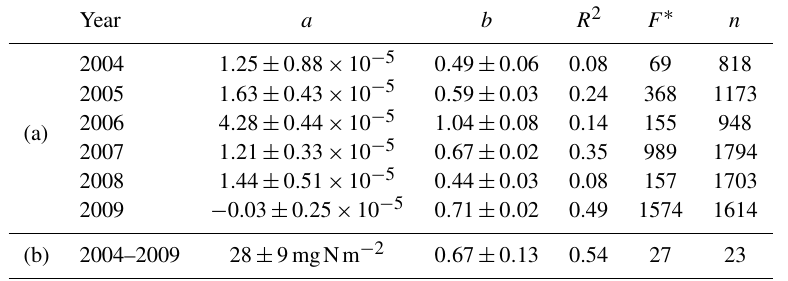
Table 3. Intercepts ( a ), slopes ( b ), coefficients of determination ( R 2 ), ratios of mean squares for regression vs. error ( F ), and number of data pairs from regressions of (a) log-transformed 4h averages of N 2 O fluxes (mgNm − 2 h − 1 ) modelled vs. measured during each year from 2004 to 2009 and (b) total N 2 O fluxes (mgNm − 2 ) modelled vs. measured during emission events following each fertilizer or manure application from 2004 to 2009 (see Fig. 3) at the Oensingen intensively managed grassland.